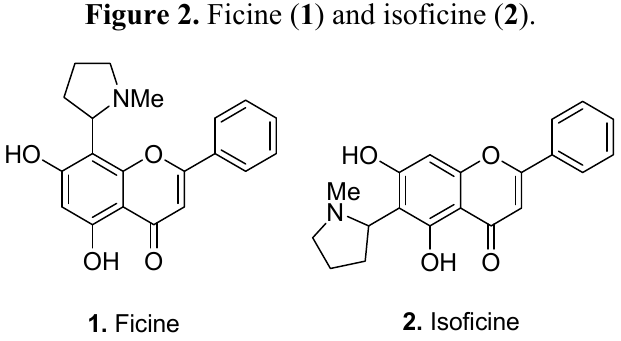
Figure 2. Ficine ( 1 ) and isoficine ( 2